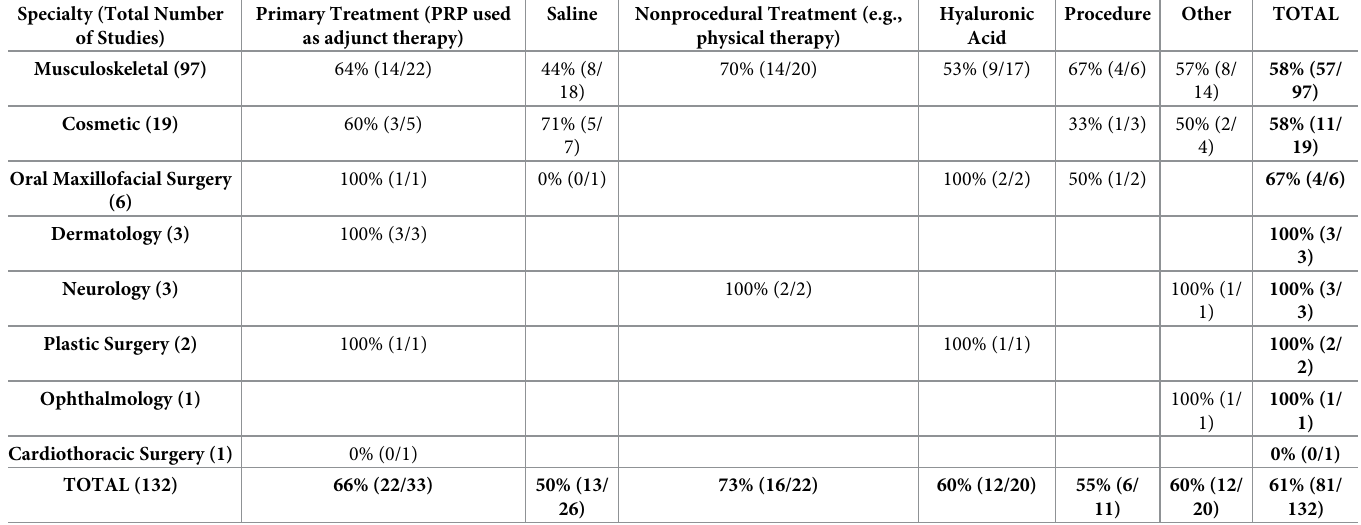
Table 5. Percentage of studies reporting favorability of platelet-rich plasma over control